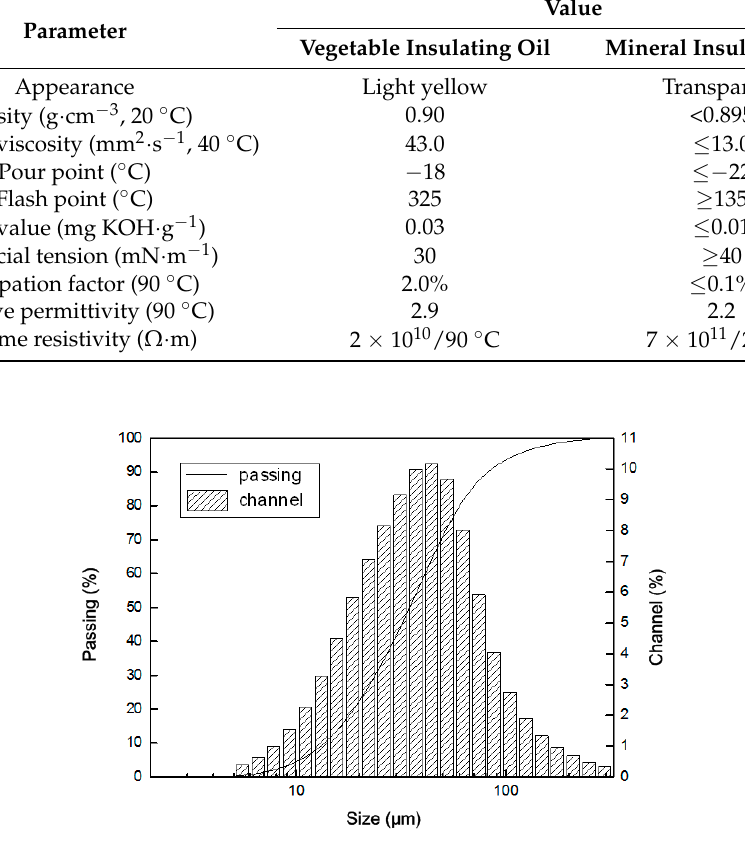
Figure 1. Typical size distribution plot of copper particles.